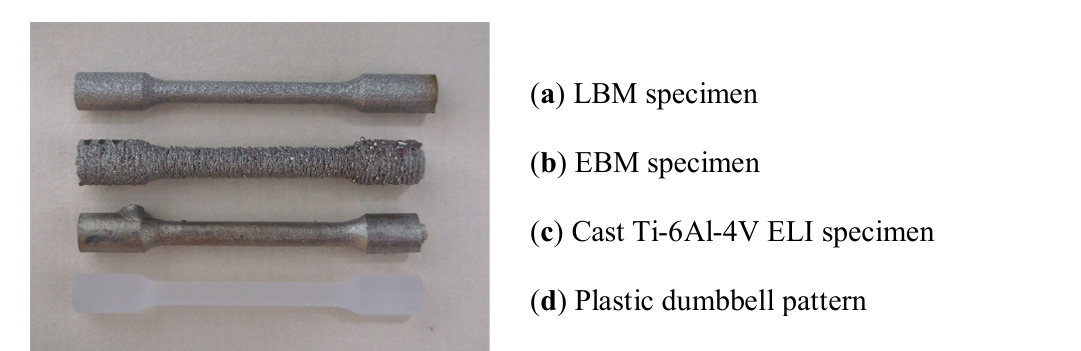
Figure 3. Exterior appearance of ( a ) an LBM specimen; ( b ) an EBM specimen; ( c ) a cast Ti-6Al-4VELI specimen; and ( d ) a plastic dumbbell